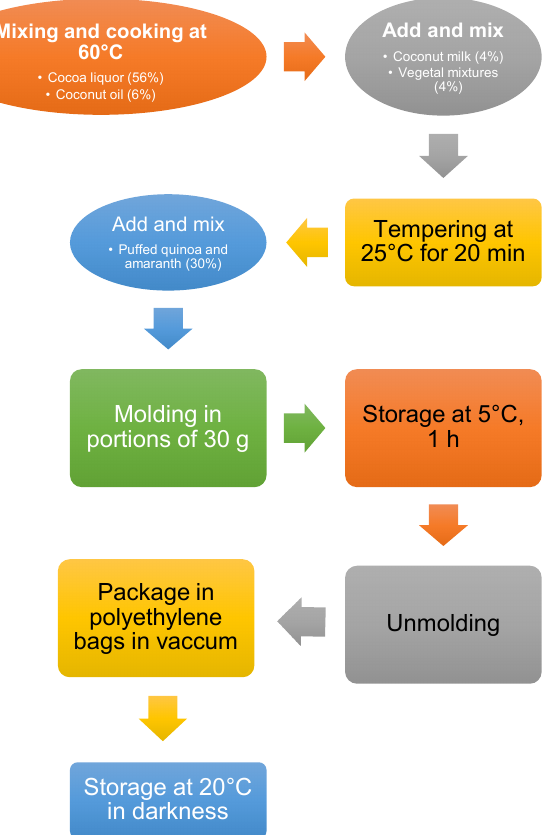
Figure 1. General methodology followed for the development of energy snacks with vegetable mixtures.